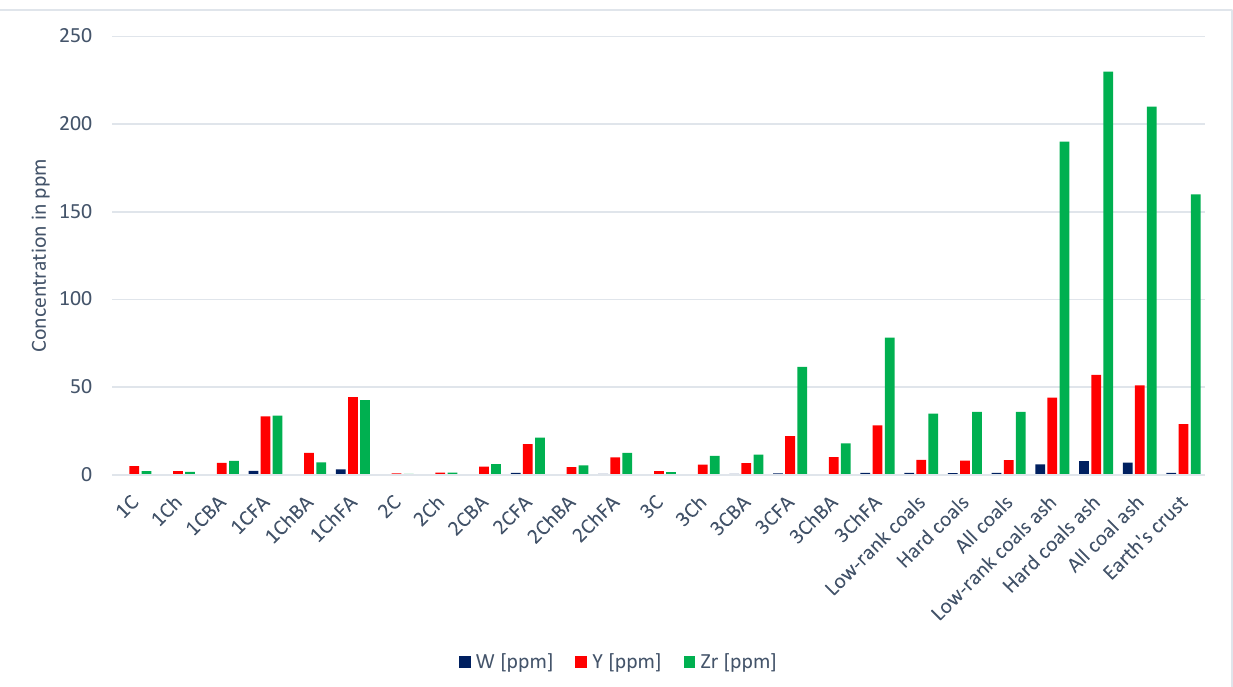
Figure 4. The W, Y, and Zr content of coal, char, ashes and their Clarke values [21].